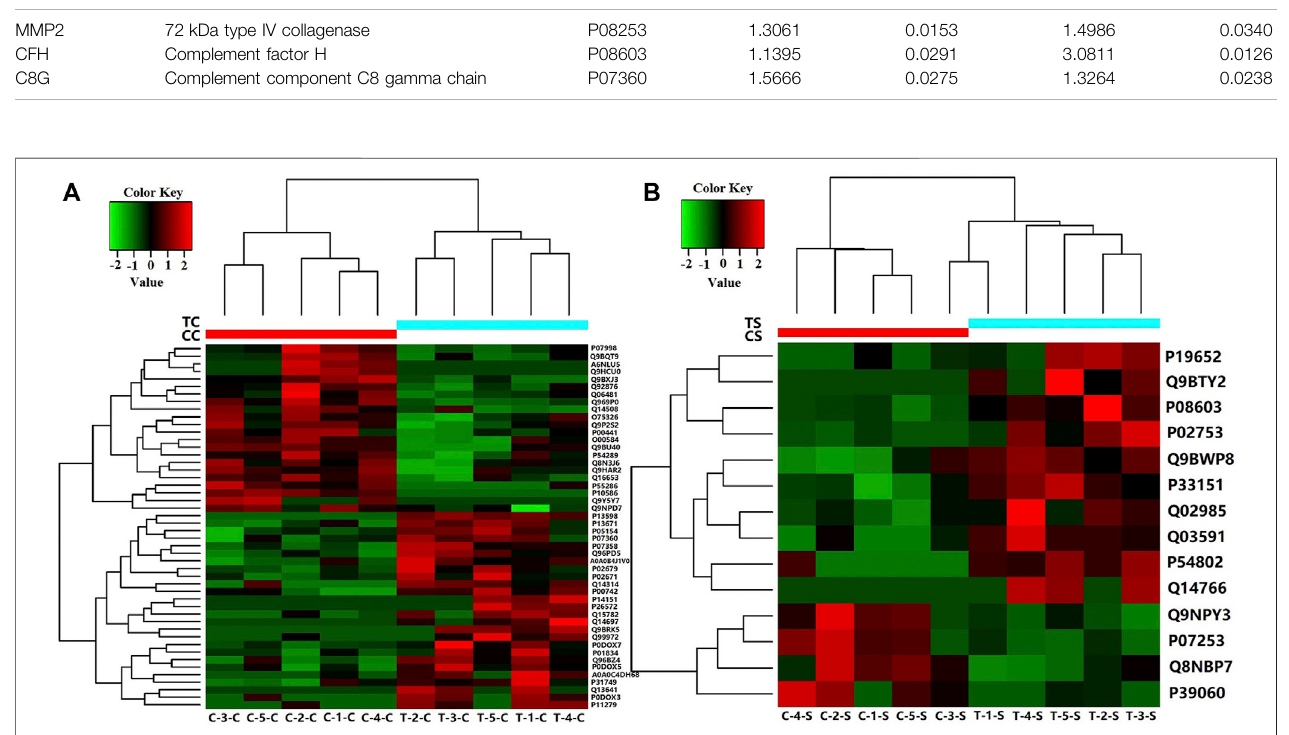
FIGURE1| Heatmap showinglevelsofdifferentiallyexpressed proteins forwhichrelativequantitativevalueswereobtainedfor fi veRRMS patients and fi veONIND patients(Fold Change =1.5). (A) Differentially expressed proteins in RRMS CSF. (B) Differentially expressed proteins inRRMS serum. CC(C-1-C,C-2-C, C-3-C, C-4-C, C-5-C), CSF from ONIND; TC (T-1-C, T-2-C, T-3-C, T-4-C, T-5-C), CSF from RRMS patients; CS(C-1-S, C-2-S, C-3-S, C-4-S, C-5-S), serum from ONIND; TS(C-1-C, C-2-C, C-3-C, C-4-C, C-5-C), serum from RRMS patients. The horizontal coordinate represents the symbol of the serum and CSF of each sample.